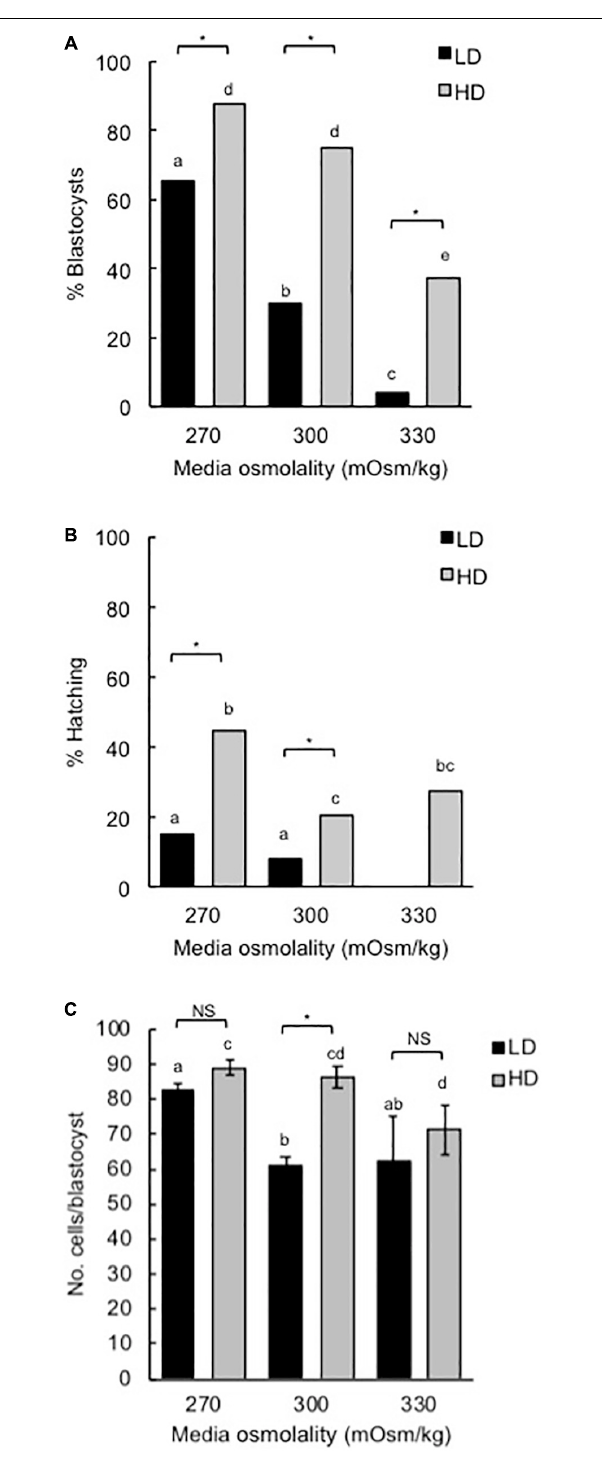
FIGURE 1 | Effect of culture density and media osmolality on the development of mouse zygotes to the blastocyst stage. Zygotes (20–22 h post-hCG) were cultured in media of different osmolality for 5 days at LD (1 embryo/100 µ L) or HD (10 embryo/10 µ L). (A) Percentage of zygotes that developed to the blastocyst stage. (B) Percentage of hatching blastocysts. (C) Cell numbers in